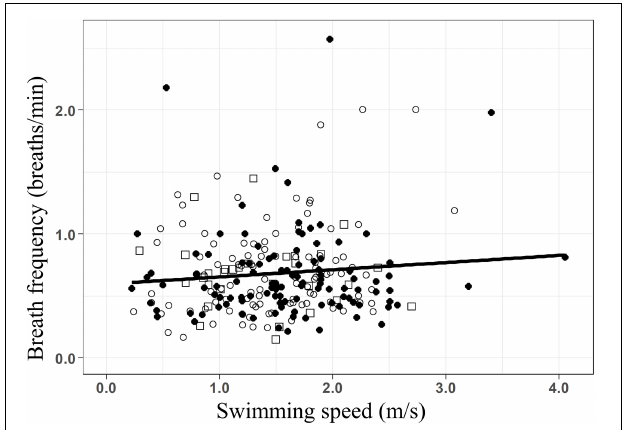
FIGURE 4 | Linear regression of the breath frequency (breaths/min) as a function of the swimming speed (m/s) for all groups of whales ( f = 0.57+0.07 × S; R 2 = 0.018; F-stat = 2.17; p -value = 0.03). Data from before ( (cid:13) ), during ( • ), and after ( (cid:3) ) the presence of the whale-watching boats.